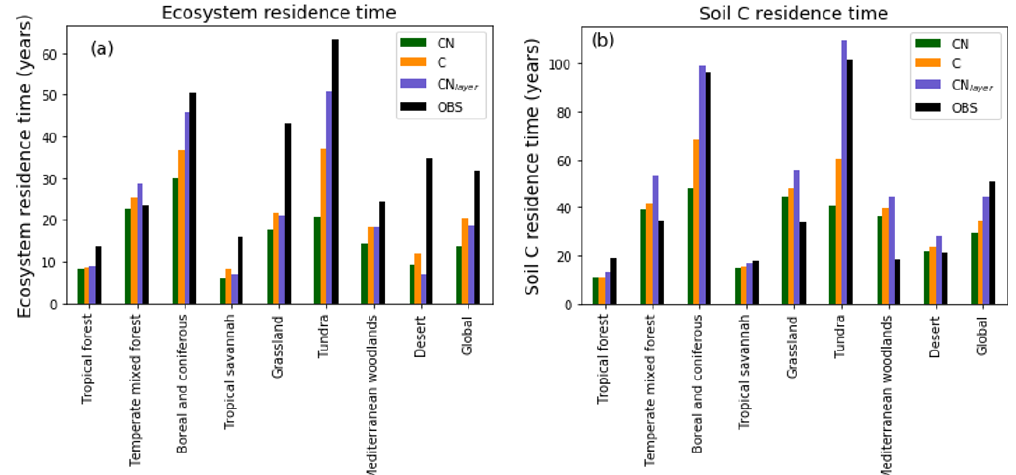
Figure 8. Biome-based (a) ecosystem turnover times and (b) soil carbon turnover times calculated on a grid cell by grid cell basis then aggregated temporally to biome level. JULES-C, JULES-CN, and JULES-CN layer are shown for the period 1996–2005. The land surface is split into biomes based on the 14 World Wildlife Fund terrestrial ecoregions (Olson et al., 2001) and characterised by Harper et al. (2018). The observed ecosystem residence times are derived from the Carvalhais et al. (2014) global dataset and the observed soil residence times are from the WISE (Batjes, 2016) soil carbon combined with the Hashimoto et al. (2015) soil respiration.